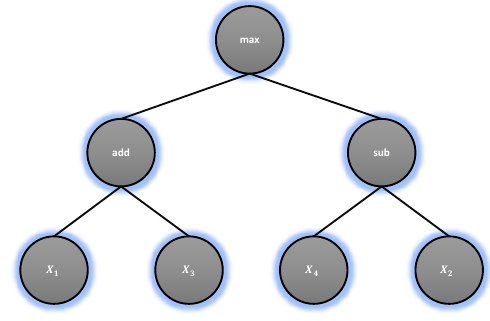
Figure 5. The max ( X 1 + X 3 , X 4 − X 2 )